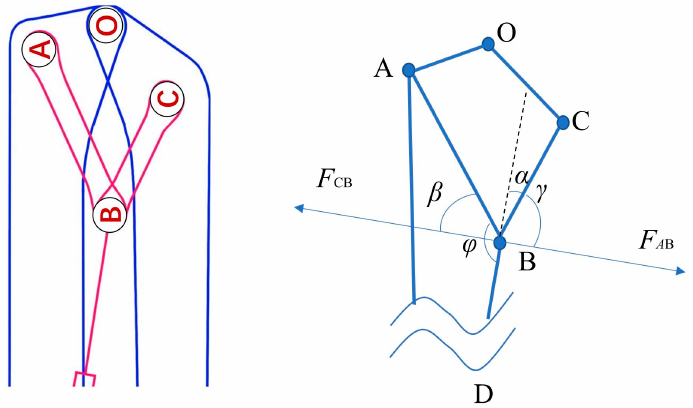
Figure 5. Schematic of cylinder #6 and its linkage mechanism.